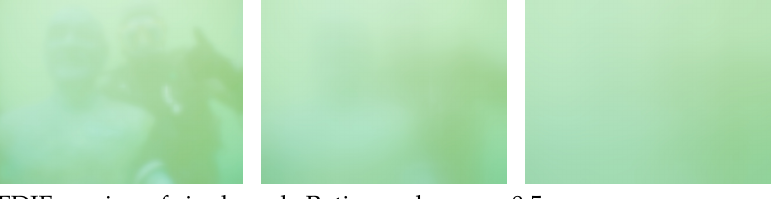
Figure 5. Comparison between the Gaussian and FDIF-based light estimation, kernel _ size = 45,243,753 from left to the right. The kernel size is chosen to be as close to the original MSR framework as possible to ensure accuracy, while the size must be odd for FDIF. In the first column, we can see that the FDIF version has kept the texture of the metal connector at the end of the breathing hoses, while the edges could barely be seen in the Gaussian